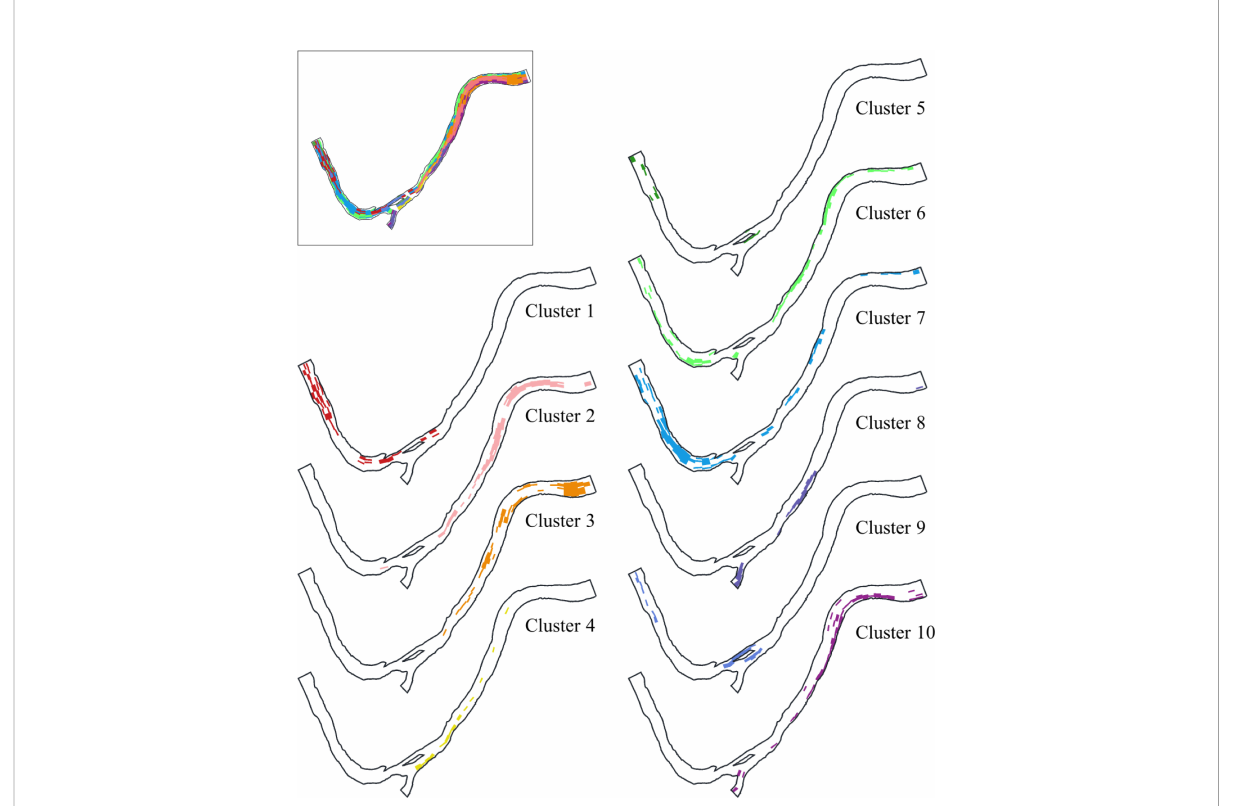
FIGURE 9 Distribution map illustrating areas of hydrologic and hydrodynamic characteristics for each